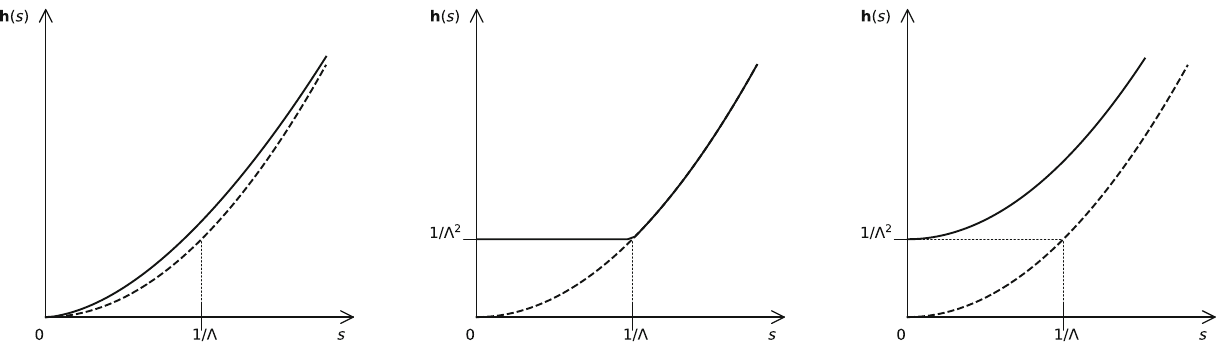
Fig. 11 In all figures a deformed function h ( s ) of the s 2 is depicted. The first one corresponds to s 2 − ε . The others are related to (96) and (97), respectively. The dash-point line corresponds to s 2